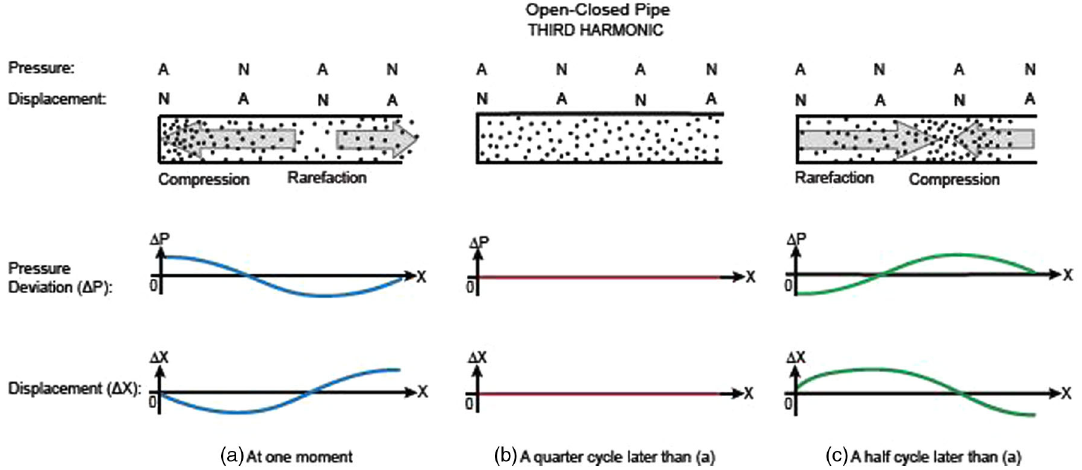
FIG. 13. Third harmonic sound standing wave in an open-closed